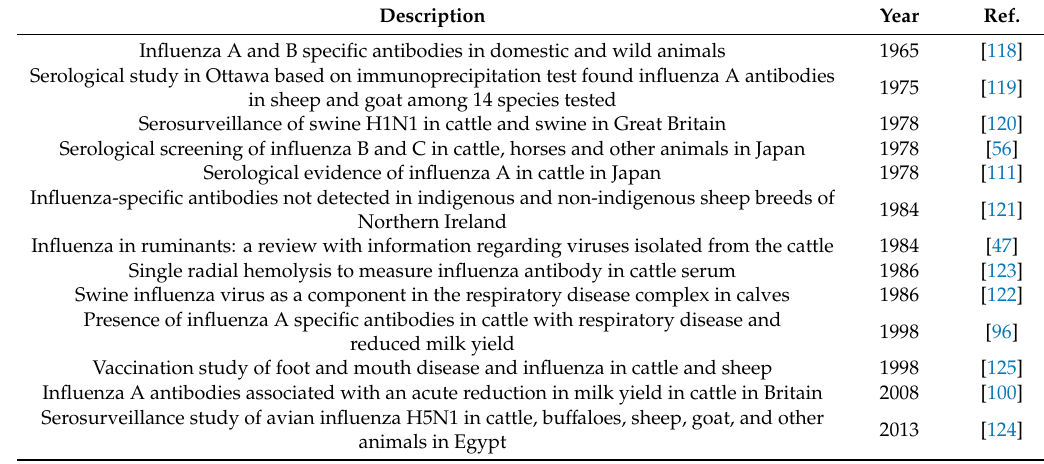
Table 2. Serosurveillance studies of influenza A associated with ruminant species in the past. Description Year